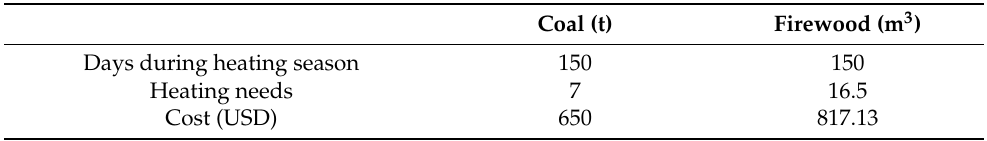
Table 10. Coil in tons and firewood in cubic meter needs and heating costs depending on the number of days for a housing unit of 100 m 2